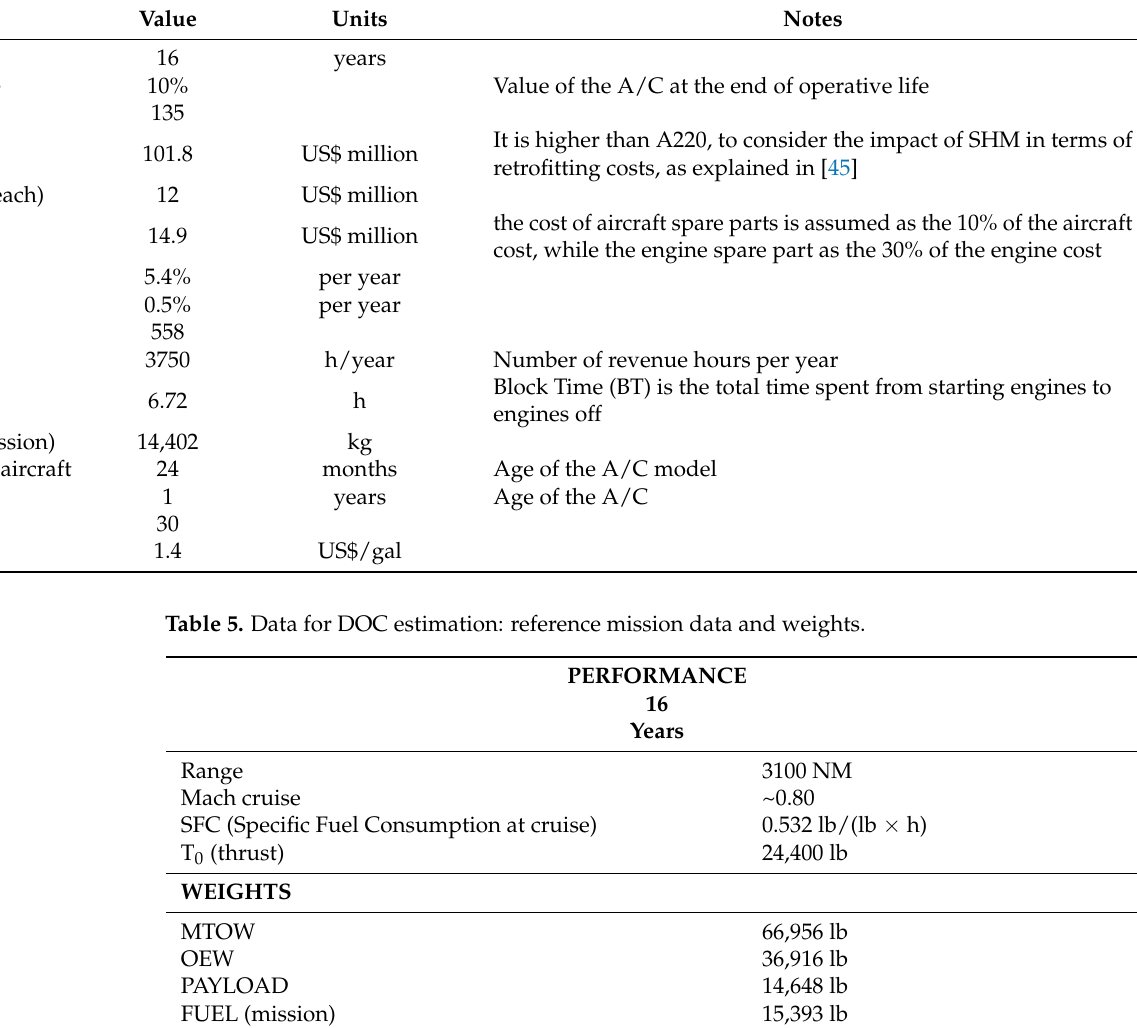
Table 4. Economic assumptions.